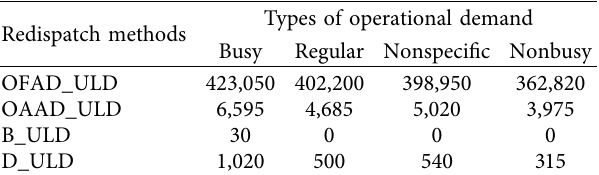
Table 8: Number of ULDs used for four redispatch methods for 500 operational days.